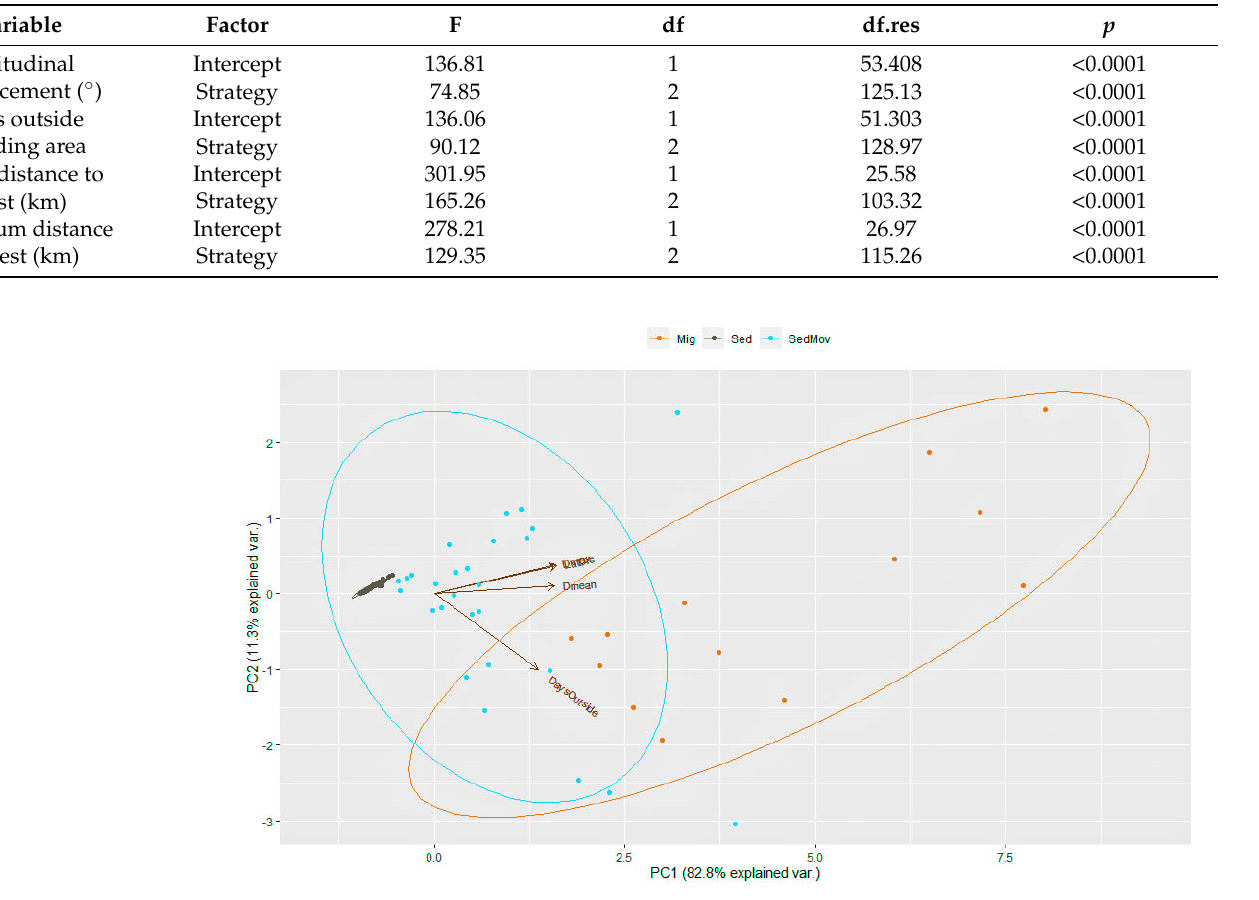
Figure 4. Principal component analysis (PCA) based on movement parameters (days outside breed- ing area, mean distance to nest, maximum distance to nest, and maximum latitudinal displacement. As depicted, 80% probability ellipsoids encompass the three strategies (orange = migratory; grey = sedentary; blue = sedentary with post-reproductive movements).